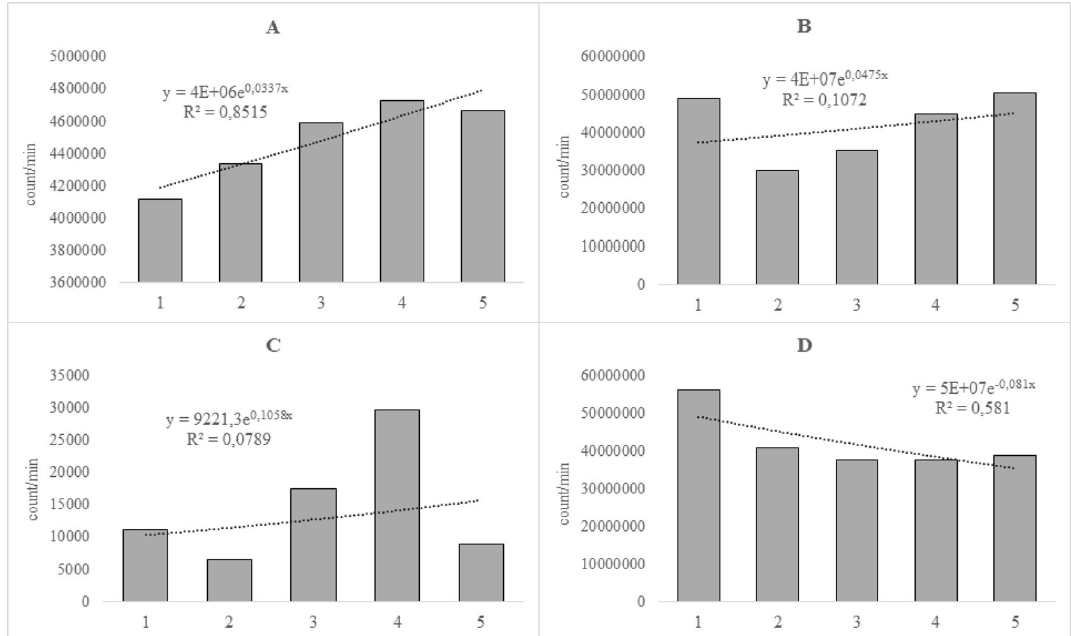
Figure 6. Examples of typical changes of biophoton emission intensity (count/min) over time in the case of water-stressed group with the fitted exponential regression models. ( A ) Near-constant after a slightly increasing tendency, ( B ) moderately increasing tendency after a sudden initial decay, ( C ) trigonometric (“cosine-like”) wave, ( D ) near-constant after an initial decay. Leaf R 2